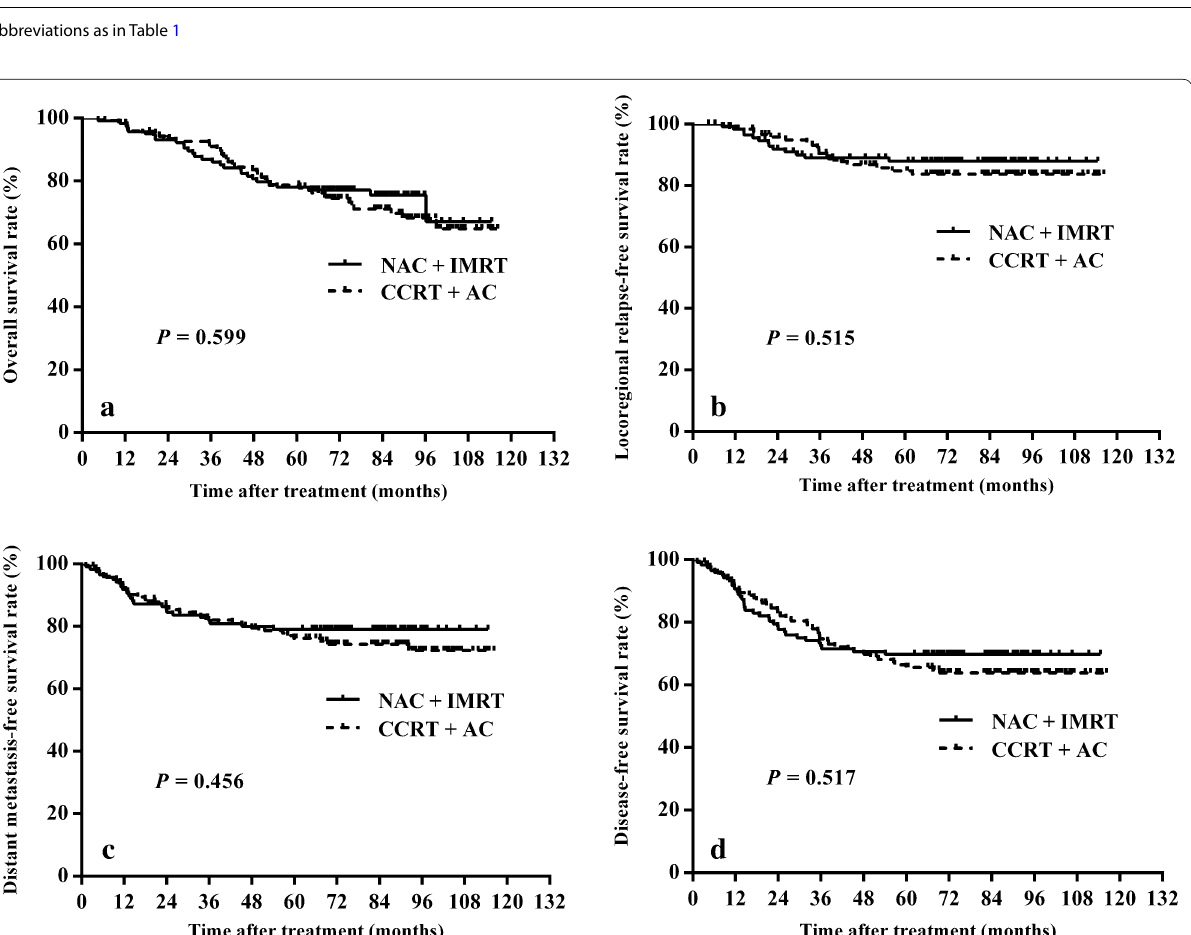
Fig. 1 Kaplan–Meier estimates of the survival of patients with locoregionally advanced nasopharyngeal carcinoma (NPC) treated by neoadjuvant chemotherapy (NAC) plus intensity‑modulated radiotherapy (IMRT) vs. concurrent chemoradiotherapy (CCRT) plus adjuvant chemotherapy (AC). a overall survival; b locoregional relapse‑free survival; c distant metastasis‑free survival; d disease‑free survival. There were no significant differences in survival between the two